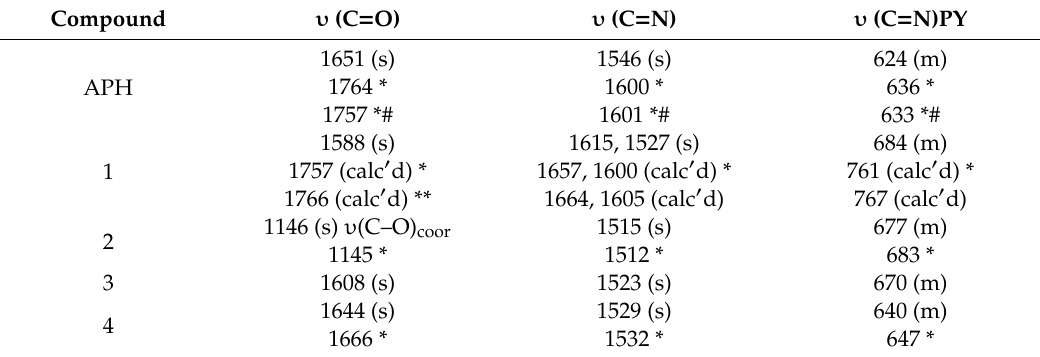
Table 1. Selected vibrational bands (cm − 1 ) of the ligand and its